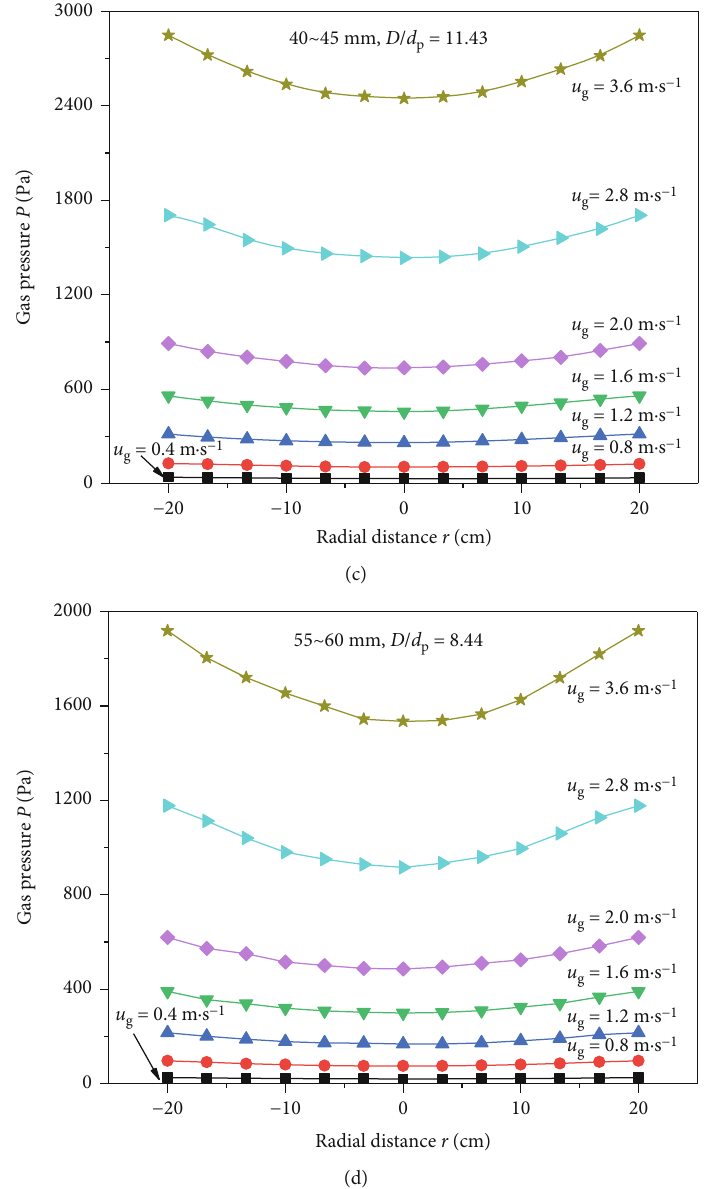
Figure 4: The radial distribution of the gas pressure ( P ) at the bed height of L = 0 mm under four kinds of particle sizes of (a) 5 ~ 10 mm, (b) 20 ~ 25mm, (c) 40 ~ 45mm, and (d) 55 ~ 60